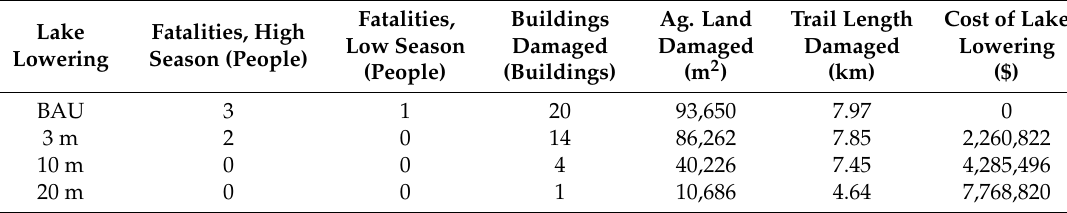
Table 5. Damage estimates for people and infrastructure at Dingboche under different Imja Lake lowering